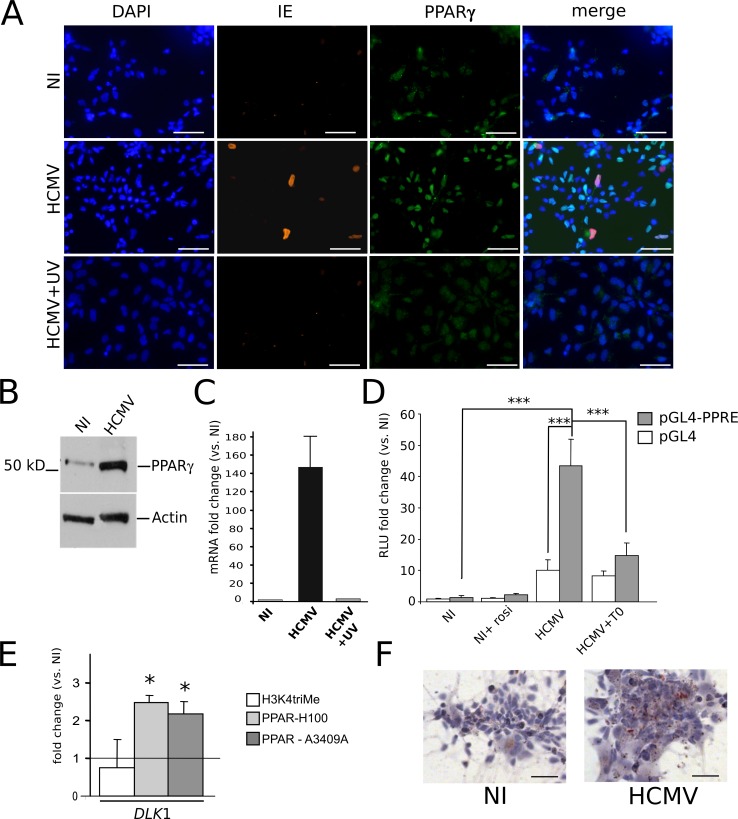
HCMV infection triggers the expression and activity of PPARγ in NSCs.(A) Immunofluorescence analysis using antibodies specific to IE or PPARγ showing strong nuclear staining of PPARγ in NSCs infected by HCMV at a MOI of 10 (HCMV), as compared to non infected NSC cultures (NI) or NSCs infected with UV-irradiated HCMV (HCMV+UV). In merged pictures, double stained nuclei appear cyan (PPARγ and DAPI) or magenta (IE and DAPI); nuclei stained by DAPI and PPARγ and IE antibodies appear purple. (B) Western blot analysis showing increased levels of PPARγ polypeptide in NSCs infected by HCMV (MOI 10) (HCMV) as compared to the uninfected control (NI), at 2 days post infection (dpi). (C) Q-RTPCR analysis showing increased levels of PPARγ transcript in NSCs infected by HCMV (MOI 10) (HCMV) as compared to the uninfected control (NI, value set to 1), or NSCs infected with UV-irradiated HCMV (HCMV+UV) at 2 dpi. Data represent means ± CI of 2 independent experiments, each being performed in triplicate. (D) Luciferase reporter assays showing non specific (pGL4) or PPARγ dependent (pGL4-PPRE) luciferase activity in uninfected NSCs (NI), uninfected NSCs treated with rosiglitazone (NI+rosi), NSCs infected by live HCMV at a MOI of 10, 2 days pi (HCMV), and NSCs infected in the presence of T0070907 (HCMV+T0). Data represent means ± CI of 3 independent experiments, each being performed in triplicate. (E) Chromatin immunoprecipitation assays using an antibody against K4-trimethylated histone 3 (H3K4triMe) as the positive control or two different antibodies against PPARγ (H100 and A3409A), showing increased occupancy by PPARγ of PPREs within the DLK1 gene in NSCs infected by HCMV, as compared with uninfected NSCs. Shown are the fold change ratio from infected versus uninfected (NI) cells. Data represent means ± CI of 2 independent experiments, each being performed in triplicate. (F) Oil red O staining showing numerous lipid vesicles in infected NSC cultures (MOI 10) (HCMV) as compared to uninfected NSCs (NI). Virus strain was AD169. Scale bar: 50 μm. *: p<0.05; ***: p<0.005.